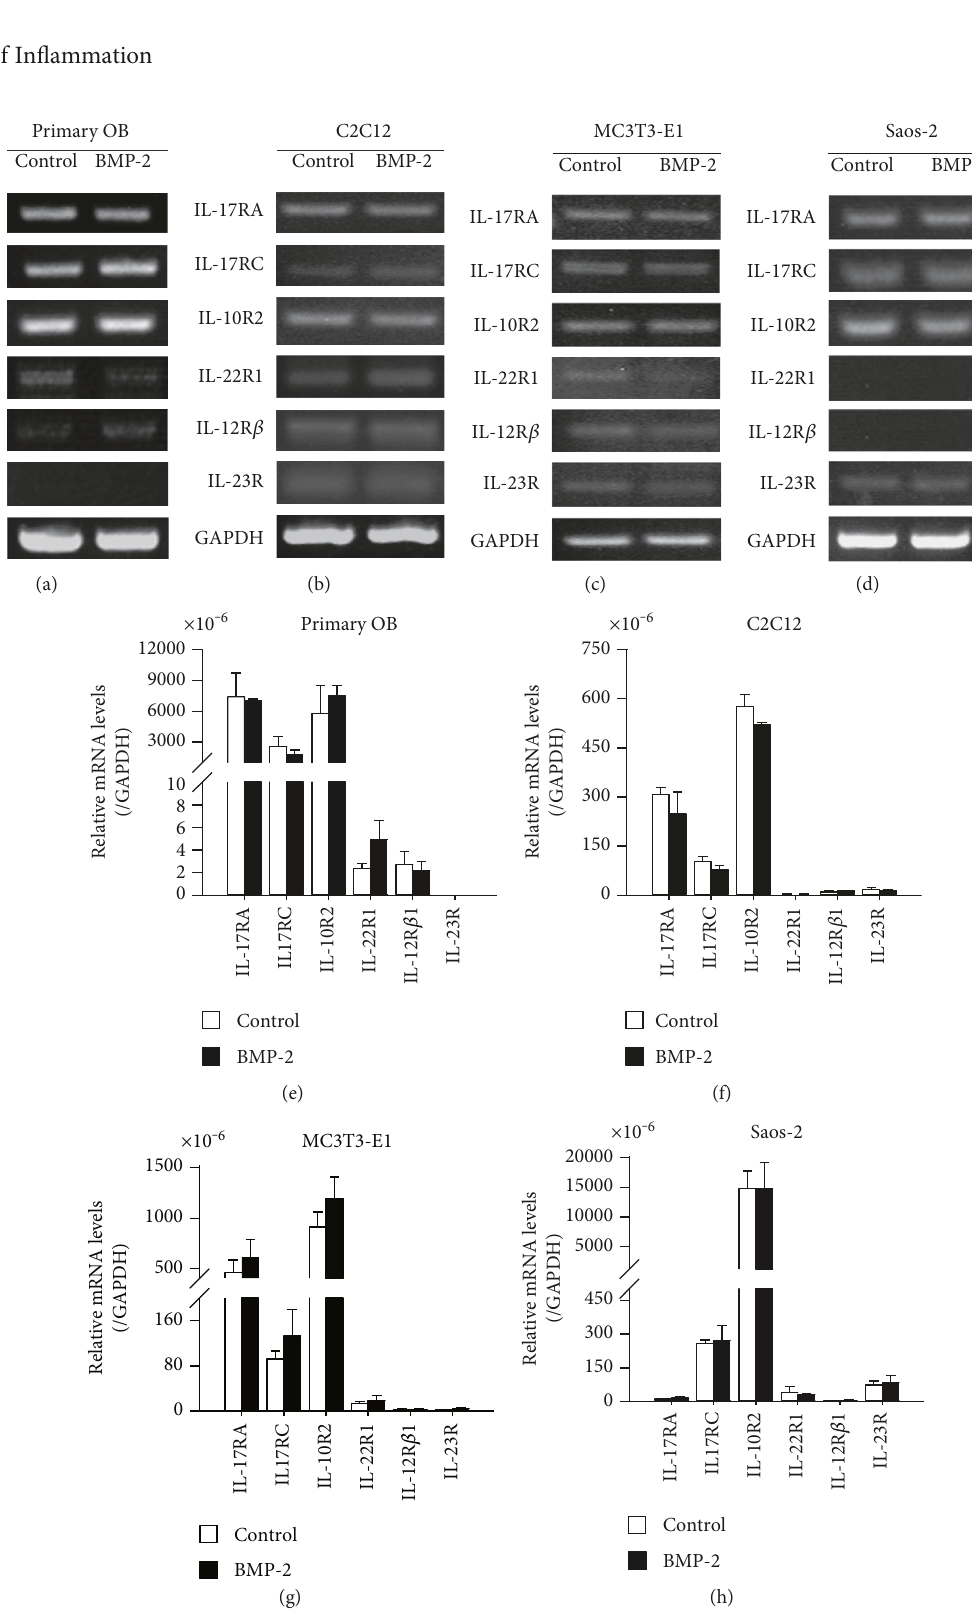
Figure 2: Gene expression levels of IL-17, IL-22, and IL-23 receptors in di ff erent osteoblast (OB) models. (a – d) The gene expression levels of IL-17, IL-22, and IL-23 receptors in primary osteoblasts, C2C12, MC3T3-E1, and Saos-2 were determined by RT-PCR analysis after the cells were cultured in the absence or presence of BMP-2 (300ng/ml); GAPDH was used as a gel loading control. (e – h) The gene expression levels of IL-17, IL-22, and IL-23 receptors in primary osteoblasts, C2C12, MC3T3-E1, and Saos-2 were analyzed by quantitative real-time RT-PCR; the copies of the receptor mRNA was standardized with the copies of GAPDH